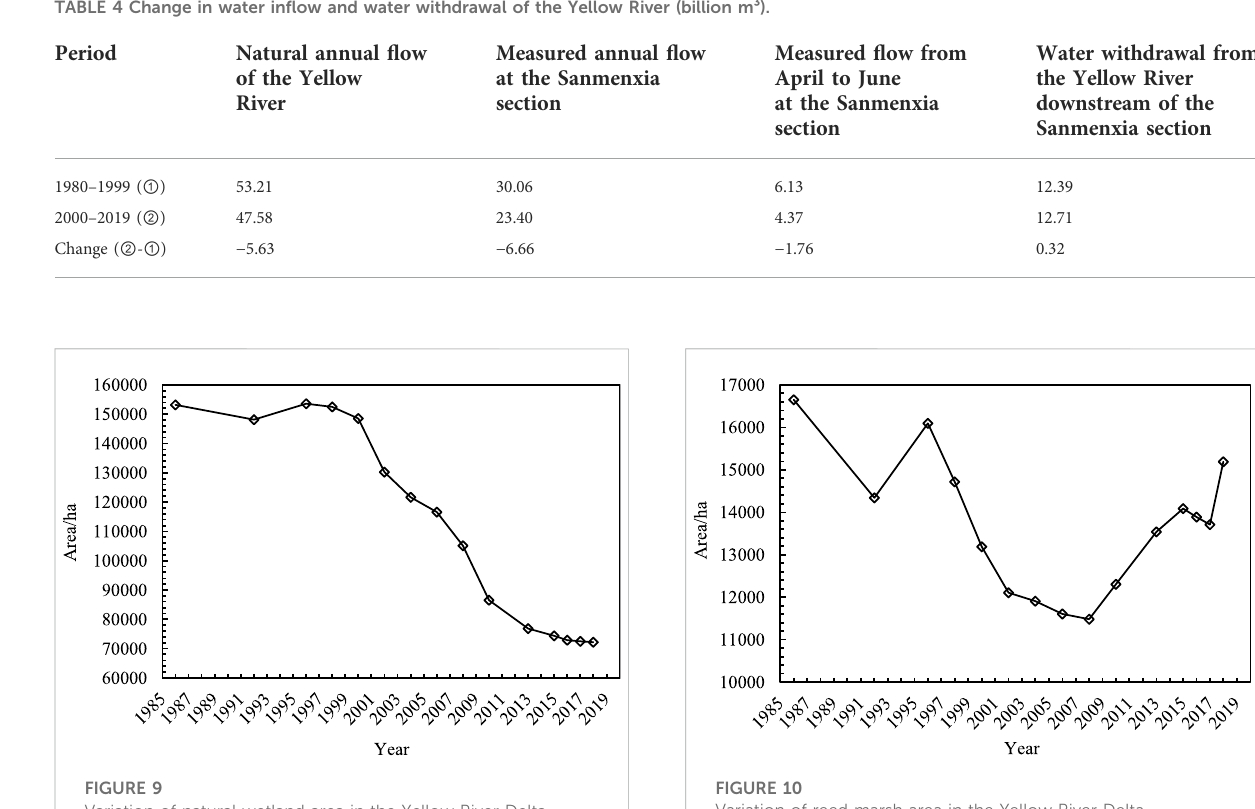
FIGURE 9 Variation of natural wetland area in the Yellow River Delta.